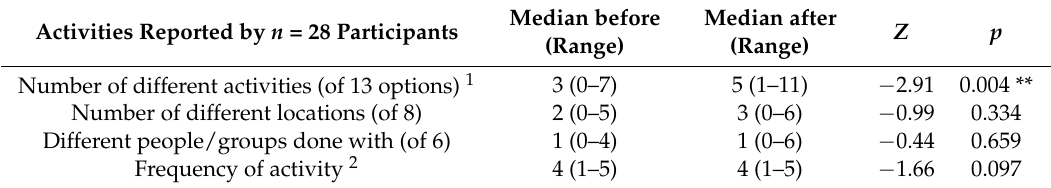
Table 3. Changes in arts participation pre to post course (corrected for Make your Mark (MYM) course attendance).